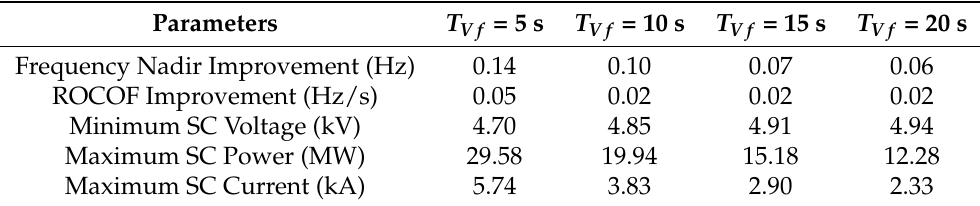
Figure 14. FFR provision from the converter-connected SC with varying time constants (from top to bottom: system frequency, SC terminal DC voltage, SC output DC power, SC output DC current). Table 6. Overview of simulation results of FFR provision from the converter-connected SC in systems with varying time